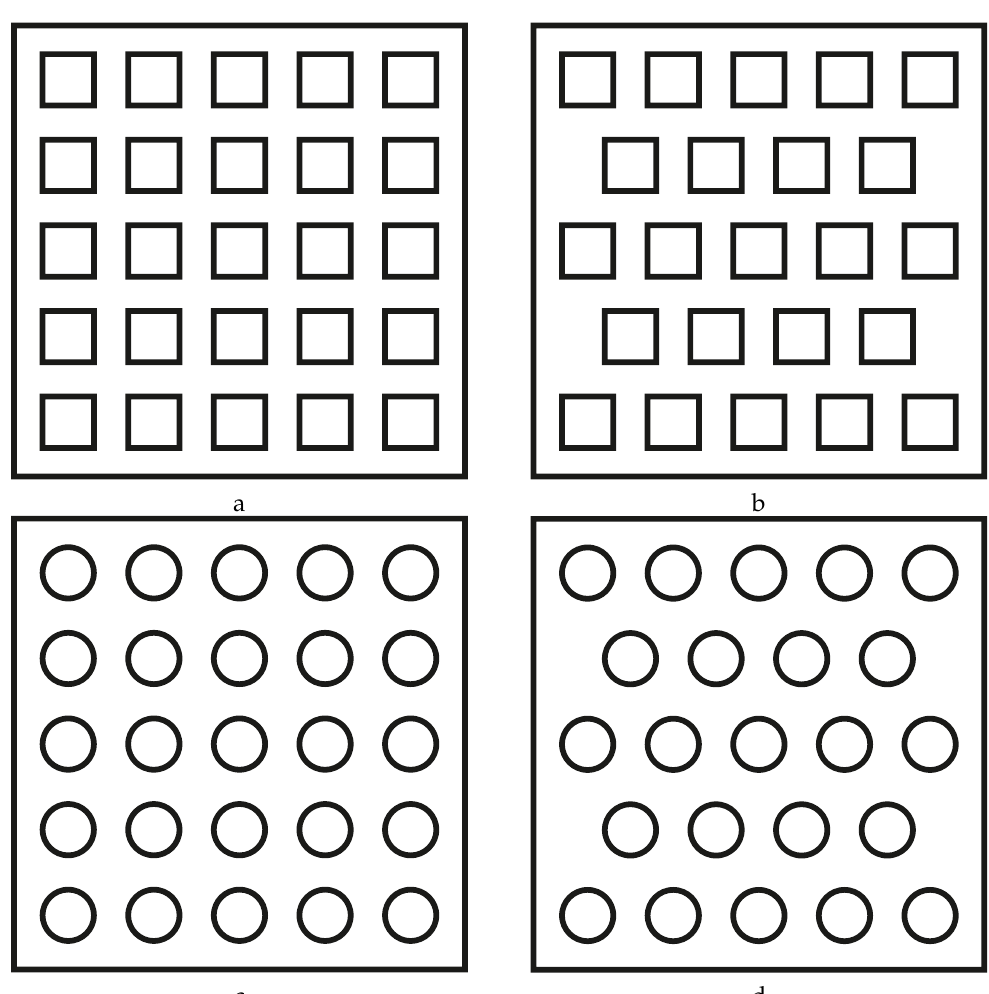
Figure 1. The mesh structure type described by the one-mode calculation of a transmission coef- ficient: a square lattice ( a , c ) and a triangular equilateral lattice ( b , d ) with square ( a , b ) and circle apertures ( c , d